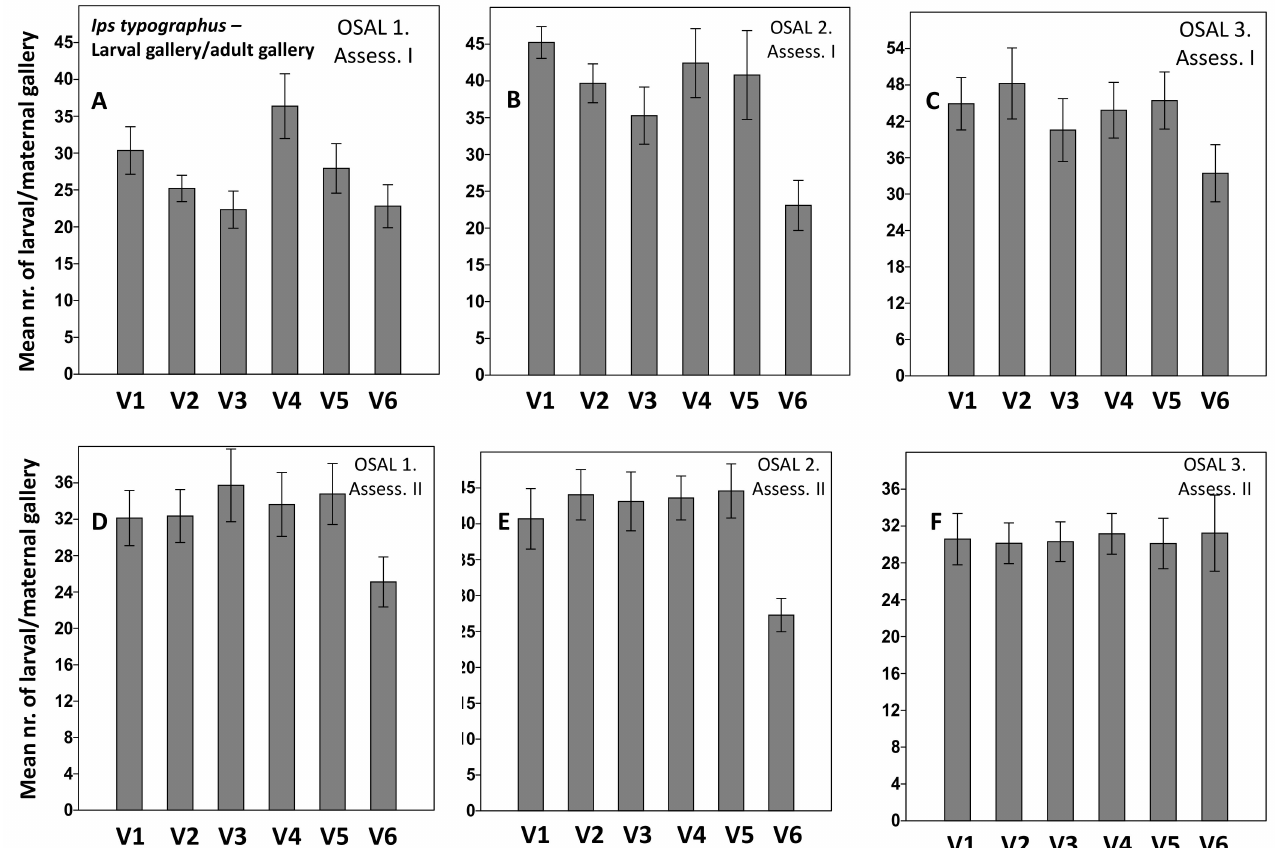
Figure 3. Average number of larval/adult gallery at first ( A – C ) and second ( D – F ) assessment. (V1) control, sprayed with water; variant 2 (V2) with Metab 75 mL/10 L water; variant 3 (V3) with Metab 105 mL/10 L water; variant 4 (V4) with Metab 135 mL/10 L water; variant 5 (V5) with Metab 165 mL/10 L water; variant 6 (V6) with lambda-cyhalothrin 50 g/L (Karate Zeon) 50 mL/10 L water. Lines above bars represent SE. OSAL is the official name of the Forest Management Agency in